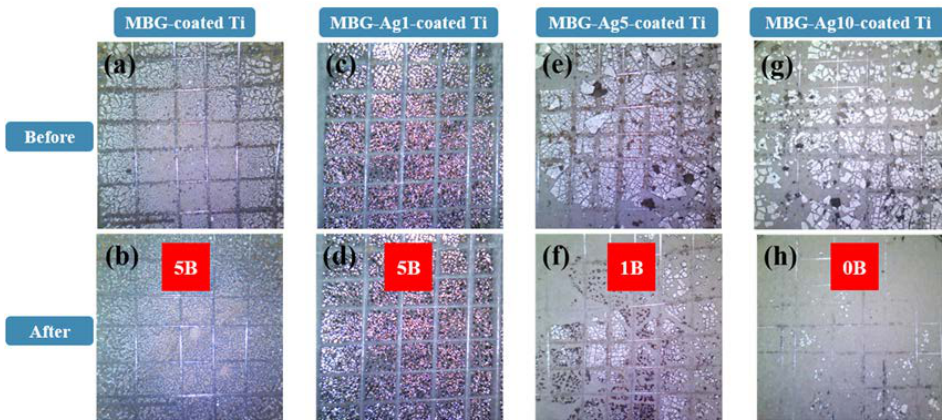
Figure 2. Adhesion strength analysis by Burger’s test (ASTM D–3359) of MBG–coated Ti ( a ) before,